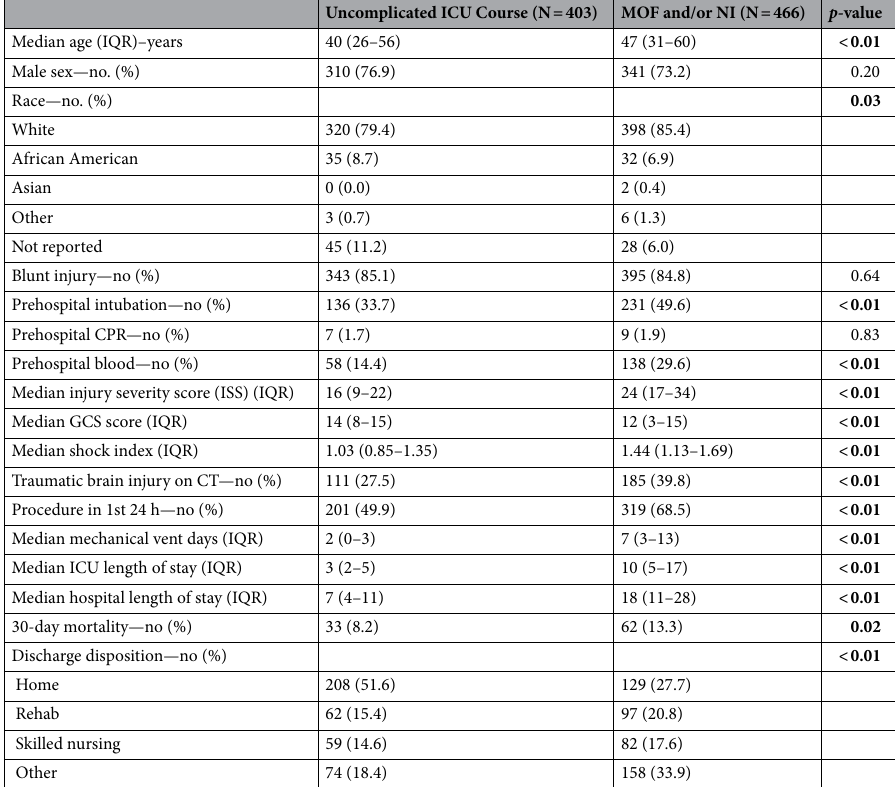
Table 1. Patient and injury characteristics and outcomes across patients with an uncomplicated ICU course versus MOF and/or NI. Significant values are in bold.